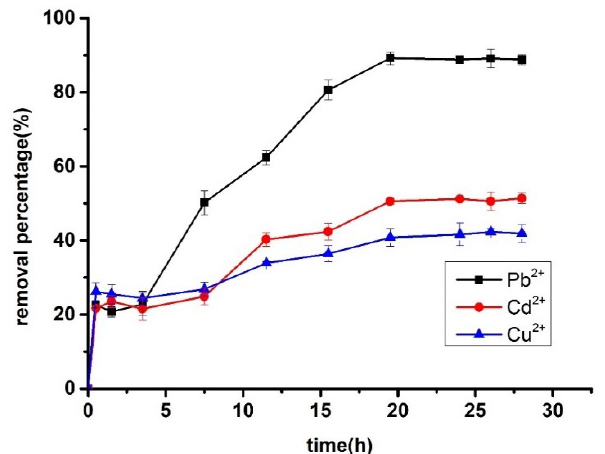
Figure 4. E ff ect of contact time on the adsorbed amount of Pb 2 + , Cd 2 + , and Cu 2 + at an initial Figure 4. Effect of contact time on the adsorbed amount of Pb 2+ , Cd 2+ , and Cu 2+ at an initial concentration of concentration of 125 mg · L − 1 , agitation speed of 150 rpm, each adsorbent dose of 12.5 g · L − 1 , and 125 mg ⸱ L −1 , agitation speed of 150 rpm, each adsorbent dose of 12.5 g ⸱ L −1 , and temperature of 30 °C. temperature of 30 ◦